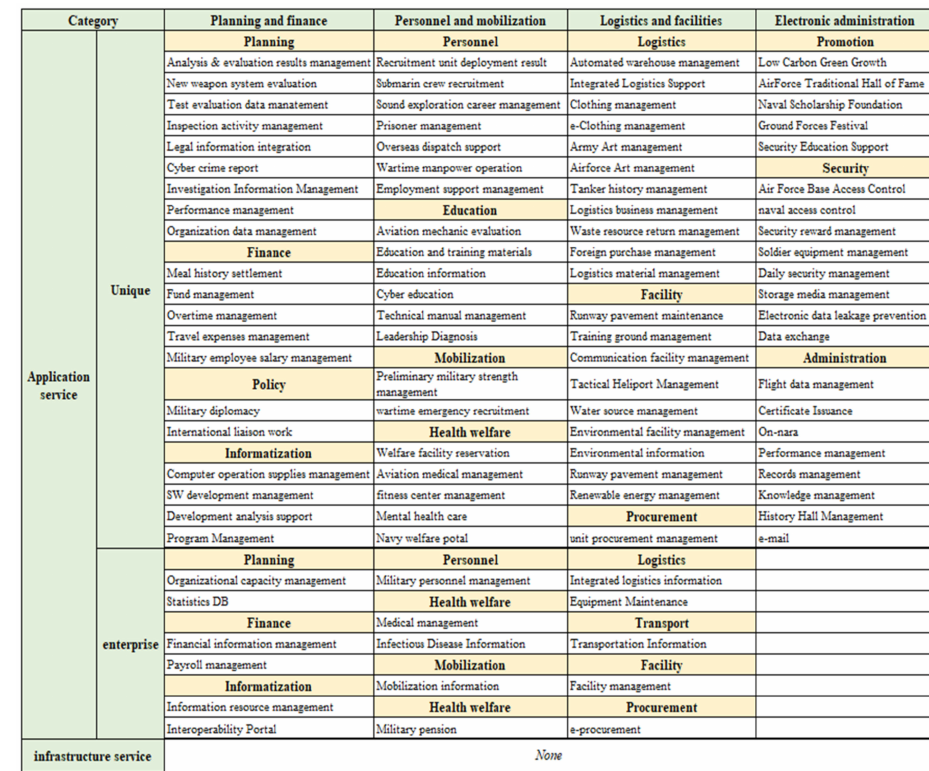
Figure 3. Example of military SaaS portfolio by applying the